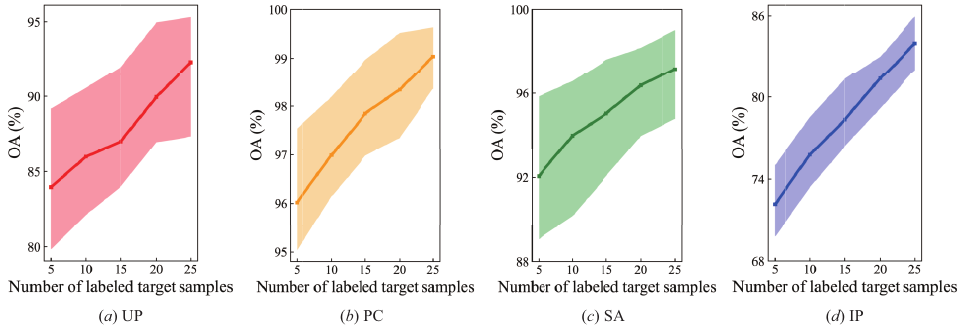
Figure 14. The influence of the number of labeled target samples on the classification accuracy. The shaded part represents the standard deviation.